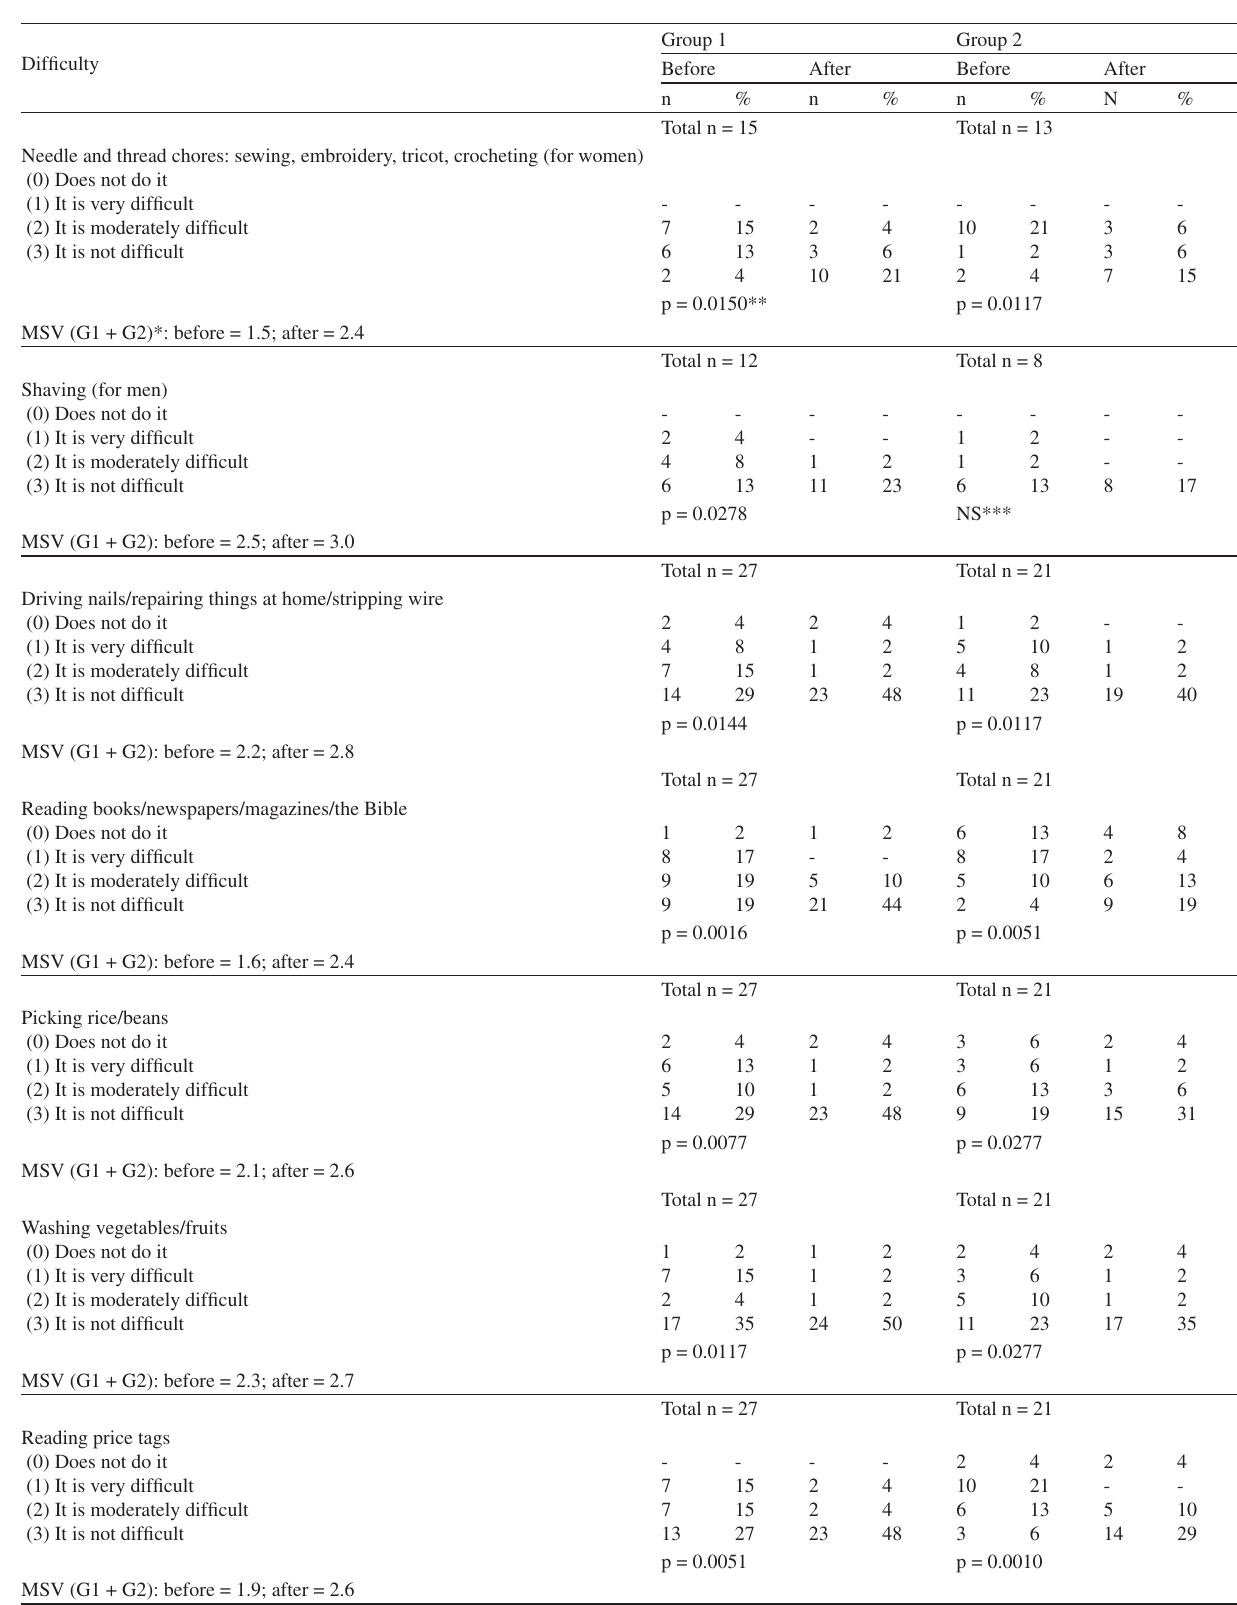
Table 2 - Subjects’ perceptions of difficulties with activities related to near vision before and after capsulotomy. Difficulty